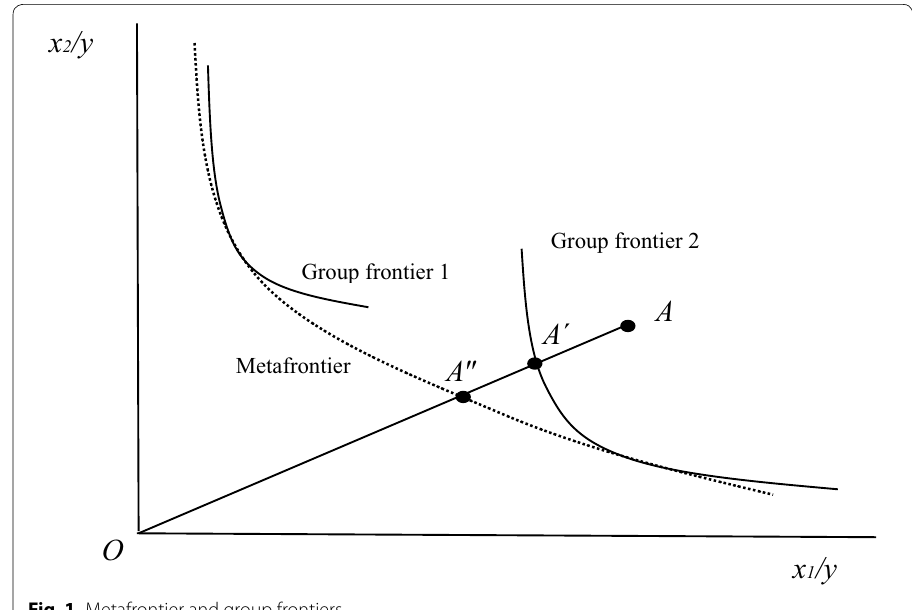
Fig. 1 Metafrontier and group